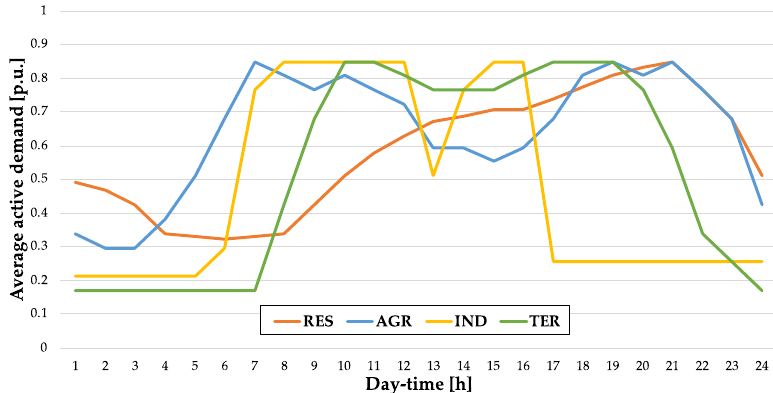
Figure 6. Load profiles of customer categories (average hourly values of active power absorbed).